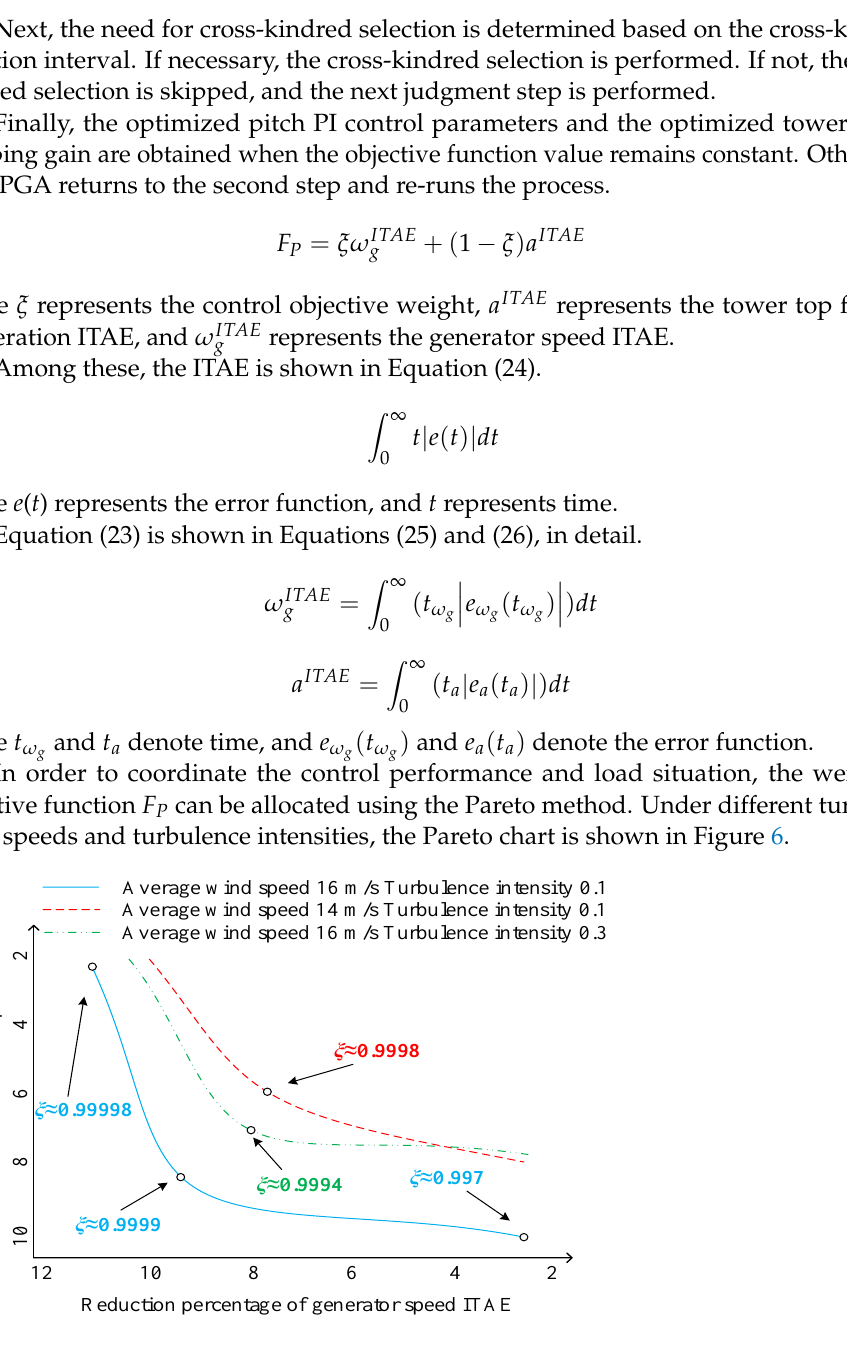
Figure 6. The Pareto chart under different turbulent wind speeds and turbulence intensities. The generator speed ITAE and tower top fore-aft acceleration ITAE all decrease with the change in ξ under the same wind condition. However, ξ is influenced by turbulence intensities and wind speeds v . The optimal value of ξ is selected on the curve using an eclectic method to enhance the control performance and reduce the load situation. Therefore, the optimal value of ξ under the turbulence intensity of 0.1 and the average wind speed of 16 m/s is 0.9999, based on the Pareto method. As an example, the optimal value of ξ at a turbulence intensity of 0.1 is shown in Equation (27). Using the above method, the equation of the optimal value of ξ for the rest of the turbulent intensities can be obtained.